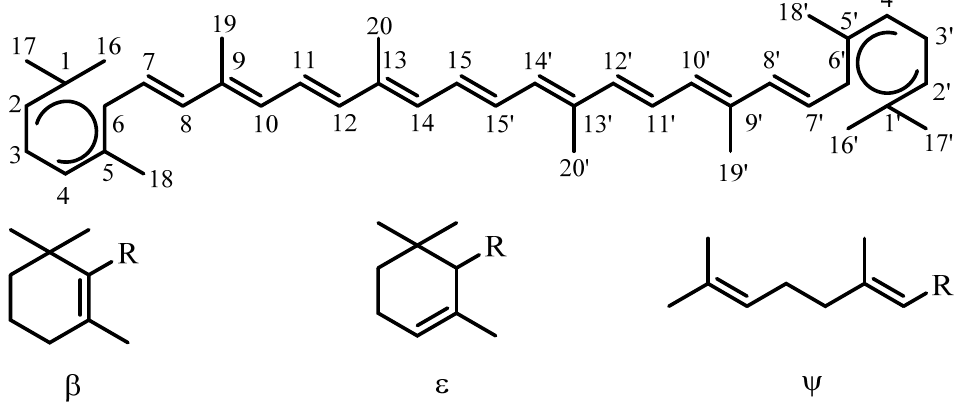
Figure 2. The numbering system of the stem name ‘carotene’ and three of the seven prefixes which designate the end groups found in natural carotenoids.